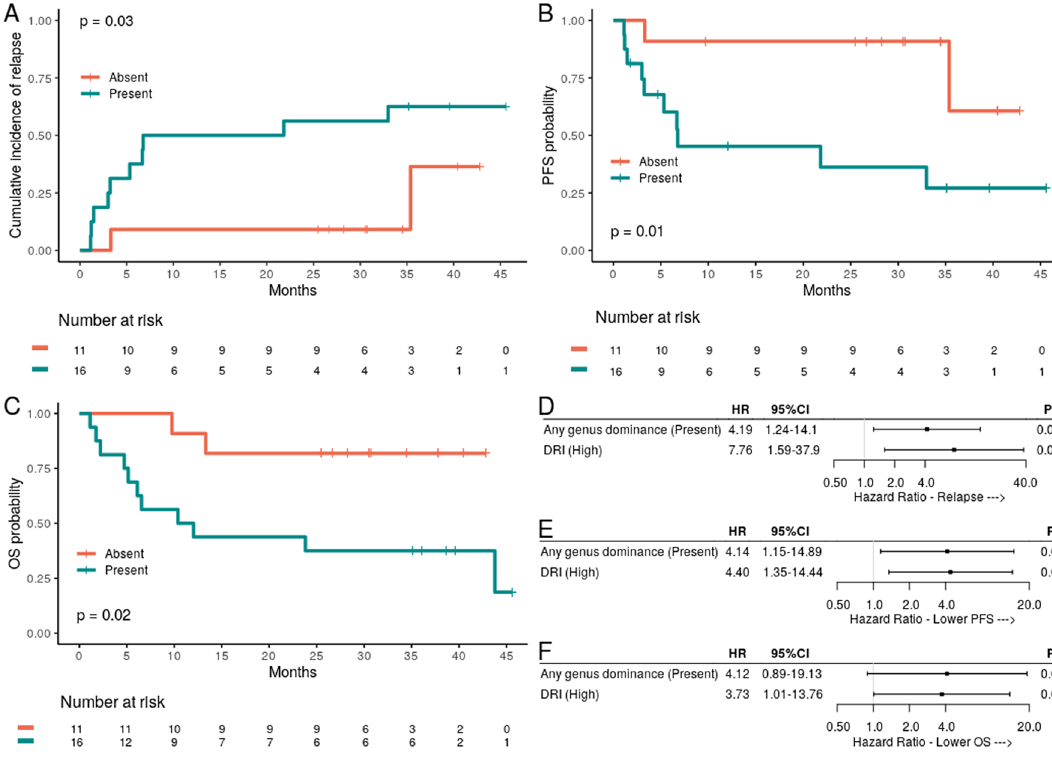
Figure 3. Association of any genus dominance with relapse, progression-free survival, and overall survival. ( A ) Cumulative incidence of relapse with patients (n = 27) stratified by any genus dominance at preconditioning. ( B ) Progression-free survival (PFS) with patients (n = 27) stratified by any genus dominance at preconditioning. ( C ) Overall survival (OS) with patients (n = 27) stratified by any genus dominance at preconditioning. ( D ) The DRI-adjusted hazard ratio for the association of dominance (relative abundance > 30%) of any genus at preconditioning and relapse (n = 27). ( E ) The DRI-adjusted hazard ratio for the association of dominance (relative abundance > 30%) of any genus at preconditioning and PFS (n = 27). ( F ) The DRI-adjusted hazard ratio for the association of dominance (relative abundance > 30%) of any genus at preconditioning and OS (n =